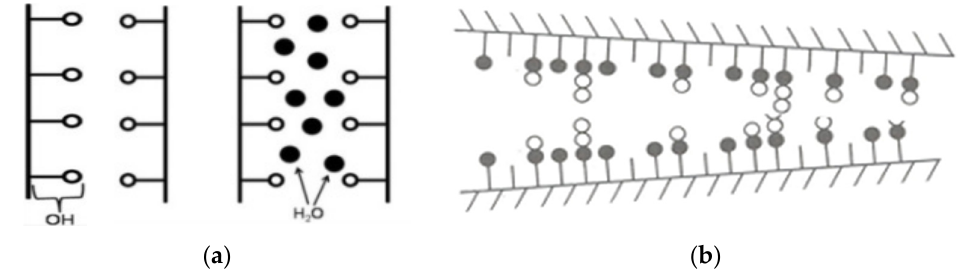
Figure 1. Models of water added to the wood cell wall. ( a ) Water molecules entering the wood cell wall; ( b ) water molecules unzipping hydrophylic hemicellulose polymer chains.